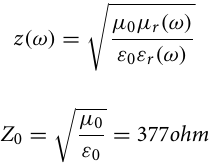
Figure 9 indicates the normalized input impedance. Input impedance has a significant contribution to moni- toring the reflection of the incident wave. The meta-atom is classified by the frequency-dependent relative